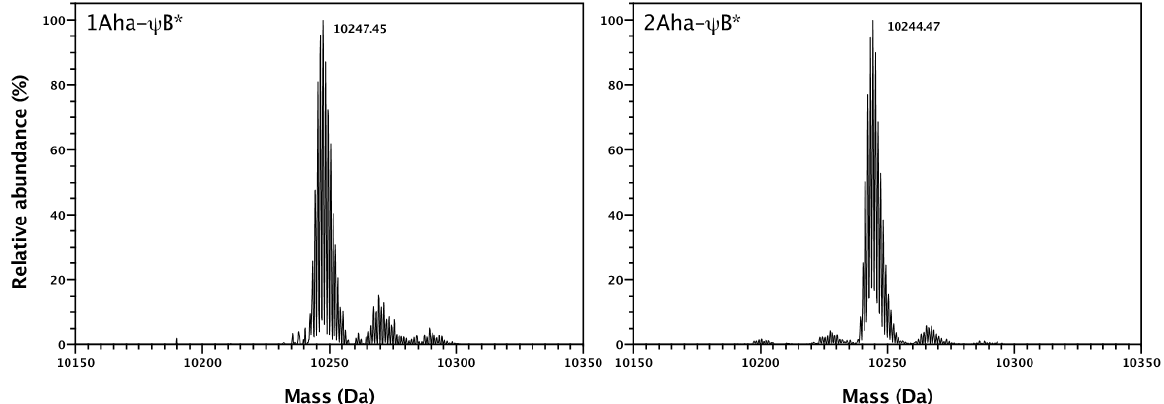
Figure 6. Click chemistry on 1Aha- ψ B* and fluorescence spectra of different ψ B* variants. ( a ) Scheme of copper(I)-catalyzed Huisgen [3+2] cycloaddition of dansyl proparglylamine to 1Aha- ψ B* and formation of N -terminal labeled dansyl- ψ B*; ( b ) Deconvoluted ESI-MS spectrum of dansyl- ψ B*. The measured molecular weight is shown in the figure. ( c ) Fluorescence emission spectra of 1Met- ψ B* (black line), 1Aha- ψ B* (red line), dansyl- ψ B* (blue solid line) upon excitation at 290 nm, and of dansyl- ψ B* (blue dotted line) and free dansyl propargylamine (green line) upon excitation at 350 nm. The data point between 575 and 600 nm relative to the blue solid line spectrum were taken out (brackets) due to strong second order diffraction grating